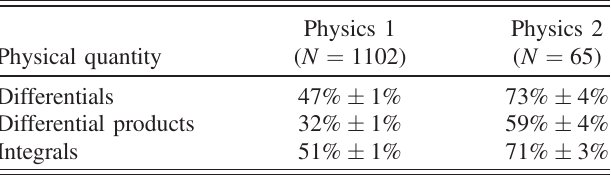
TABLE III. Assessment descriptive statistics. Mean scores with 1 standard error are shown for both the Physics 1 and Physics 2 populations for each set of assessment